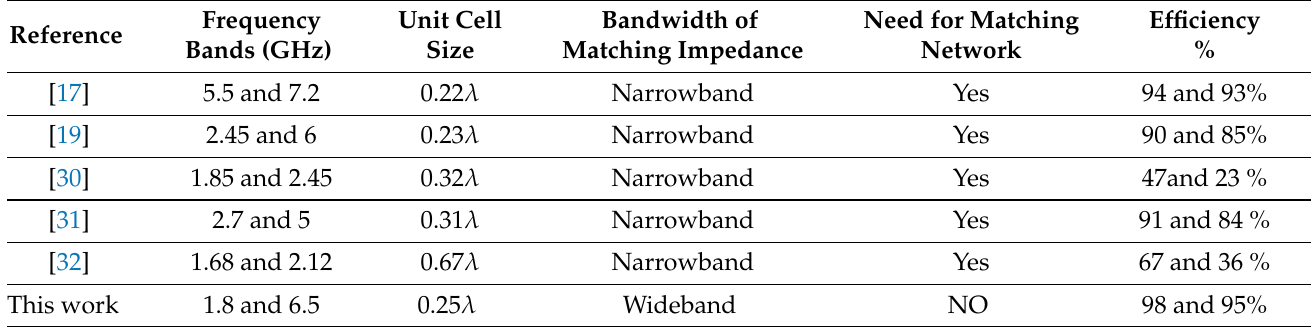
Table 1. A comparative study of the proposed dual-band and polarization-independent metasurface array with various state-of-the-art published